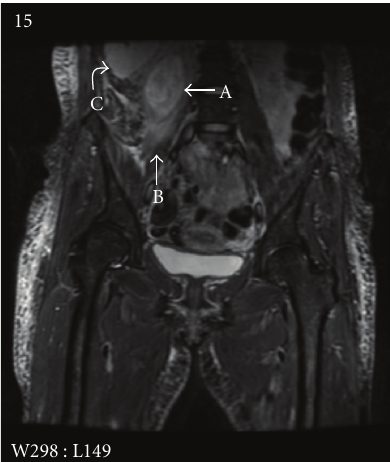
Figure 2: CT, axial view. The loculated right-sided psoas abscess extends to the skin surface